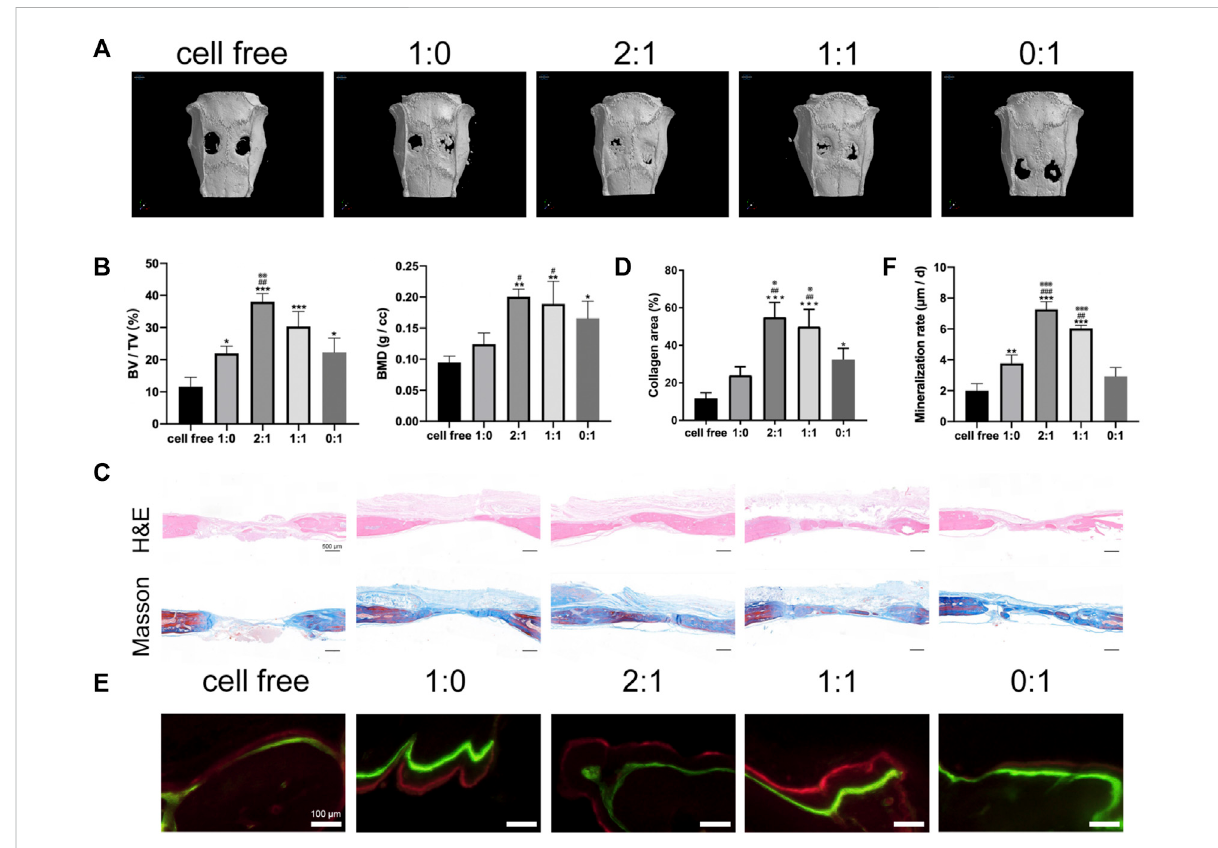
FIGURE 3 Bone repair using microtissue constructs in rat calvarial bone defects. (A) . Micro-CT images of calvarial defect repair effect at 3 months after surgery. (B) . Quantitative analysis of new bone volume/tissue volume (BV/TV) and bone mineral density (BMD). (C) . Histological analysis by H&E and Masson ’ strichromestaining.Scalebar=500 μ m. (D) .Quantitativeanalysisofpercentageofcollagenindefectarea.(*comparedtocellfreegroup.# comparedto1:0group. ※ comparedto0:1group.*/ ※ p < 0.05,## p < 0.01,*** p < 0.001). (E) .Tissuemineralizationshownby:green=calcein injected 3 weeks before euthanasia, red = alizarin red injected 3 days before euthanasia. Scale bar = 100 μ m. (F) . Quantitative analysis of mineralization rate (MAR, the average distance between two lines divided by the number of days). (* compared to cell free group. # compared to 1: 0 group. ※ compared to 0:1 group. */ # p < 0.05, **/ ## / ※※ p < 0.01, ***/ ### / ※※※ p <